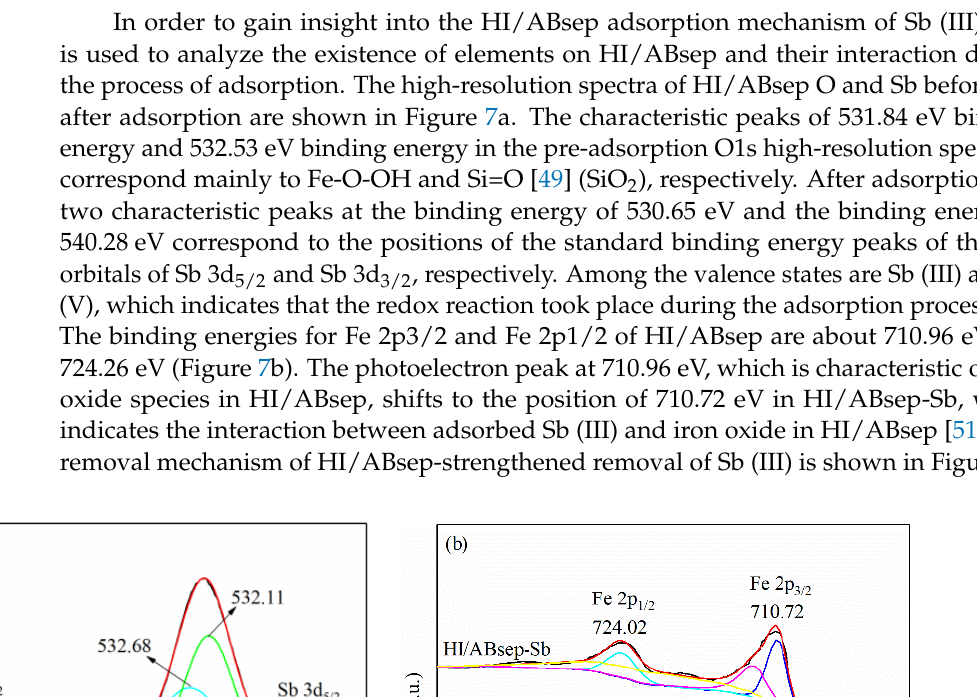
Table 4. Thermodynamic parameters for Sb (III) adsorption by HI/ABsep.